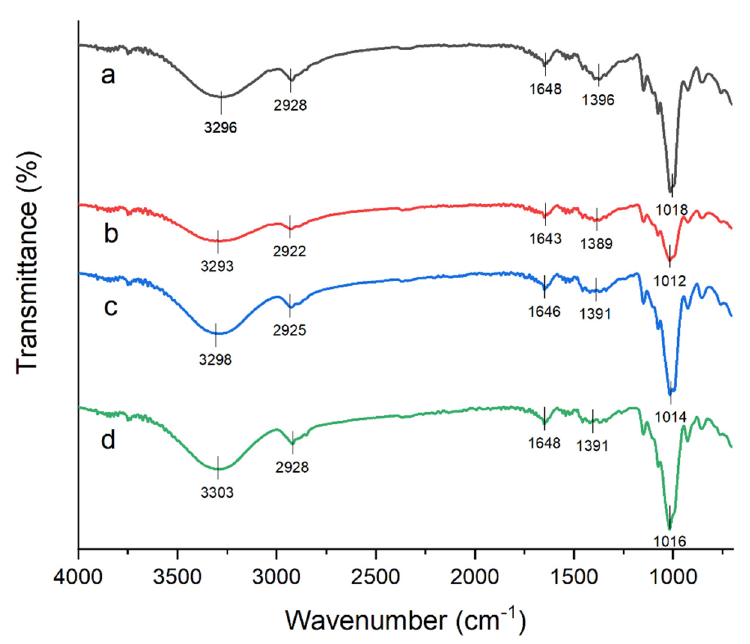
Figure 2. FT-IR spectra of ( a ) neat sago starch matrix, ( b ) 5% agar, ( c ) 10% agar, ( d ) 15% agar.